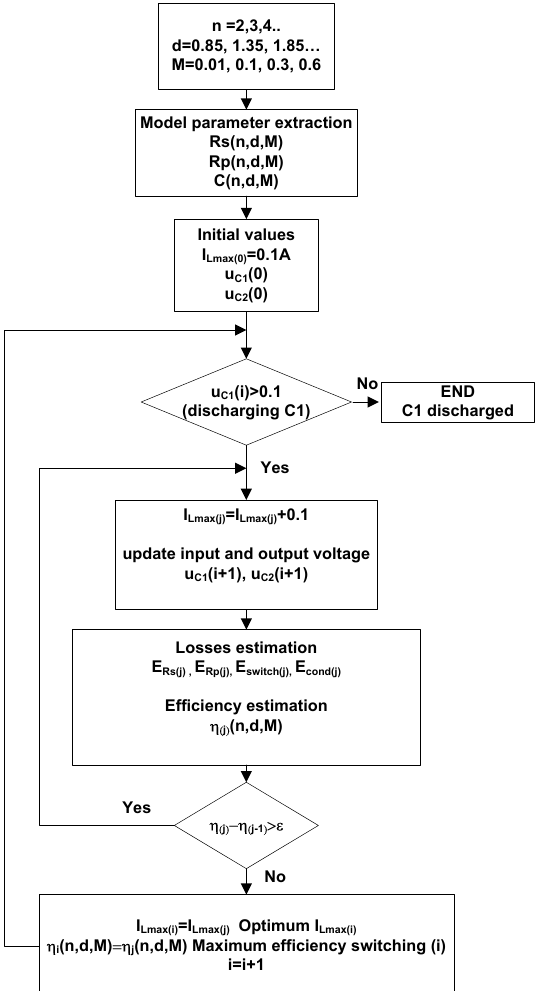
Figure 8. I calculation process during the energy Lmax